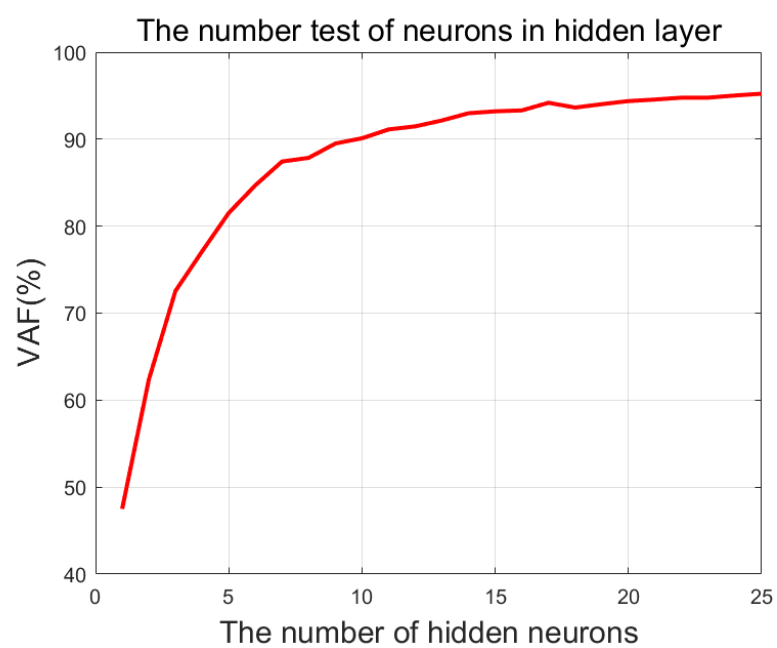
Figure 4. The ten subject’s average predict accuracy evaluated by the variance accounted for (%) with the increase of neurons. the increase of